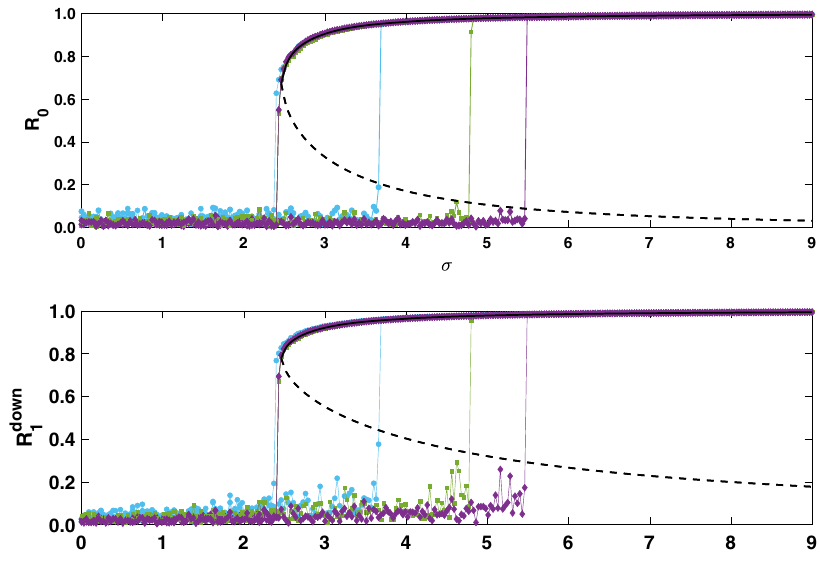
Fig. 5 The backward and the forward discontinuous phase transition on fully connected networks. The order parameters R 0 (circles) and R down (squares) are plotted as a function of the coupling constant σ on a fully connected network. The solid and the dashed lines indicate the stable branch and the unstable branch predicted by Eq. (59). Simulations (shown as data point) are here obtained by integrating numerically Eqs. (34) and (35) for a fully connected network of N = 500 (cyan circles), N = 1000 (green squares), and N = 2000 (purple diamonds) with Ω 0 = Ω 1 = 0 and (rescaled) τ 0 = τ 1 = 1. The backward transition is perfectly captured by the theoretical prediction (solid black line) and is affected by fi nite-size effects very marginally. The forward transition is instead driven by stochastic fl uctuations and moves to higher values of σ as the network size increases. This is in agreement with the fact that the unstable branch of the self-consistent solution (black dashed line) does not cross the x -axis for any fi nite value of the coupling constant σ